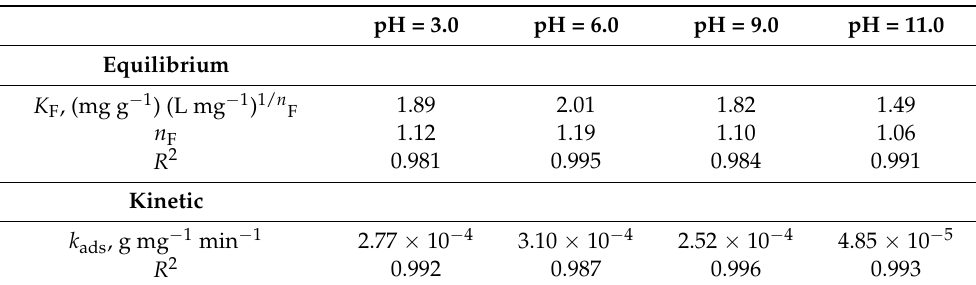
Table 1. Summary of the kinetic parameters obtained from the pseudo-second-order and equilibrium model determined via the Freundlich isotherm model for the adsorption of phenol on the GAC’s surface at a temperature of 20 ◦ C and different pH values. pH = 3.0